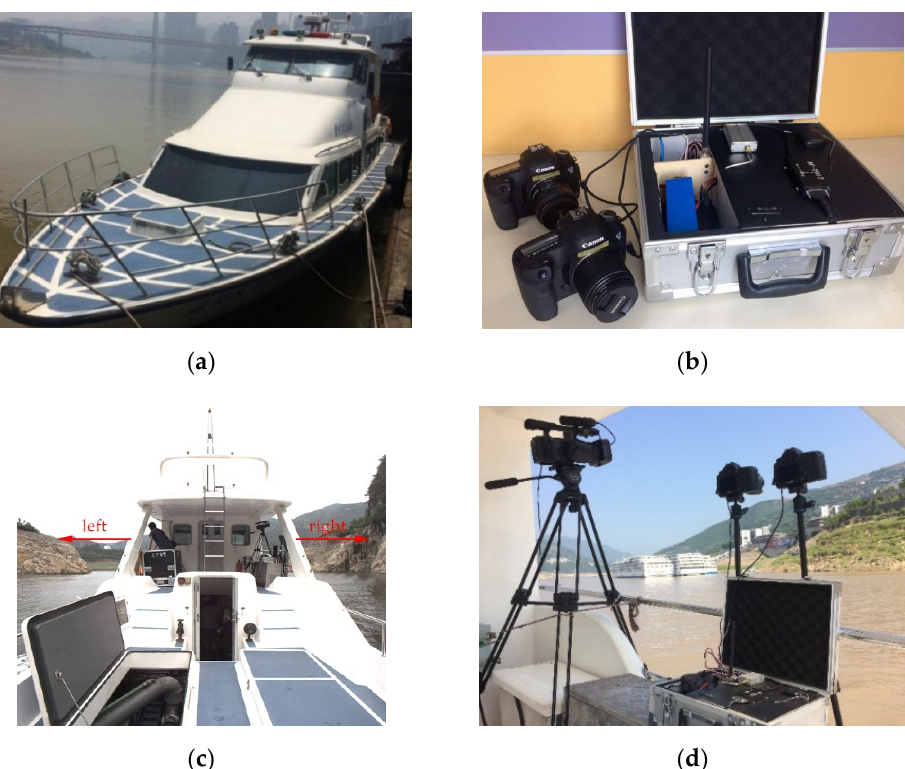
Figure 4. Shipborne mobile photogrammetry system and installation. ( a ) ship platform; ( b ) imaging control system and cameras; ( c ) installation position of the imaging system; ( d ) a close view of the imaging system.